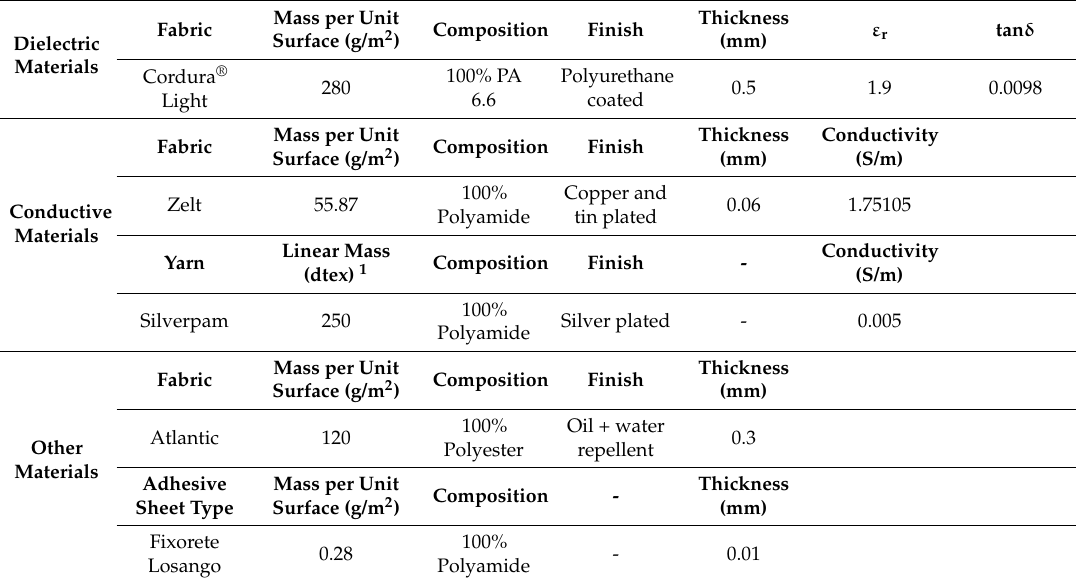
Table 2. Characteristics of the textile materials used to develop wearable antennas.